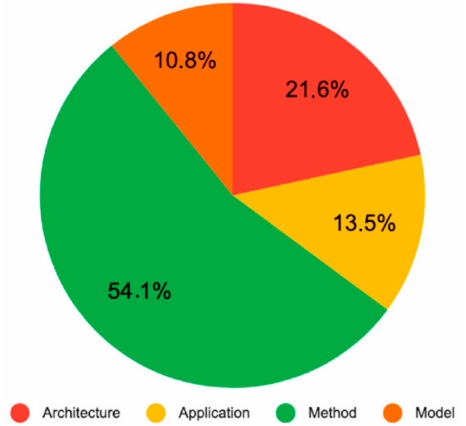
Figure 14. Research Approaches in Big Data and ML